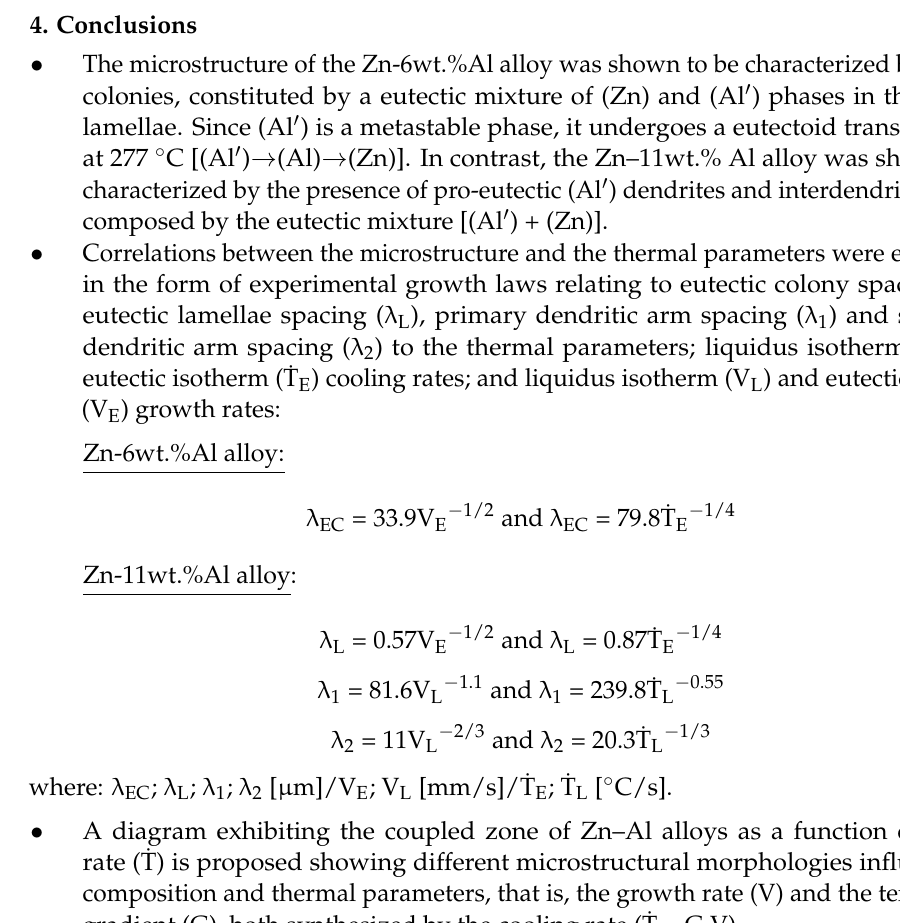
Figure 19. Vickers microhardness as a function of the lamellar eutectic spacing for the studied Zn–Al alloys.